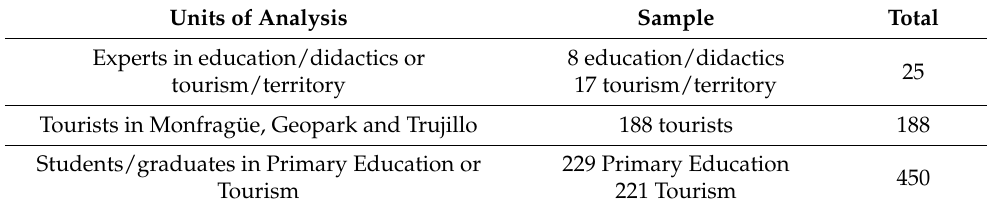
Table 2. Units of analysis and participating